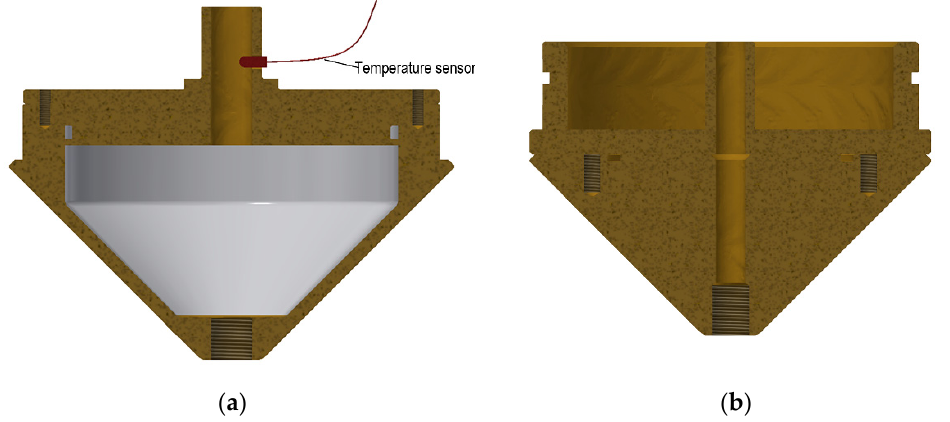
Figure 6. The 3D models of the drill tips used in the experiments: ( a ) hollow thermal tip; ( b ) solid thermal tip.